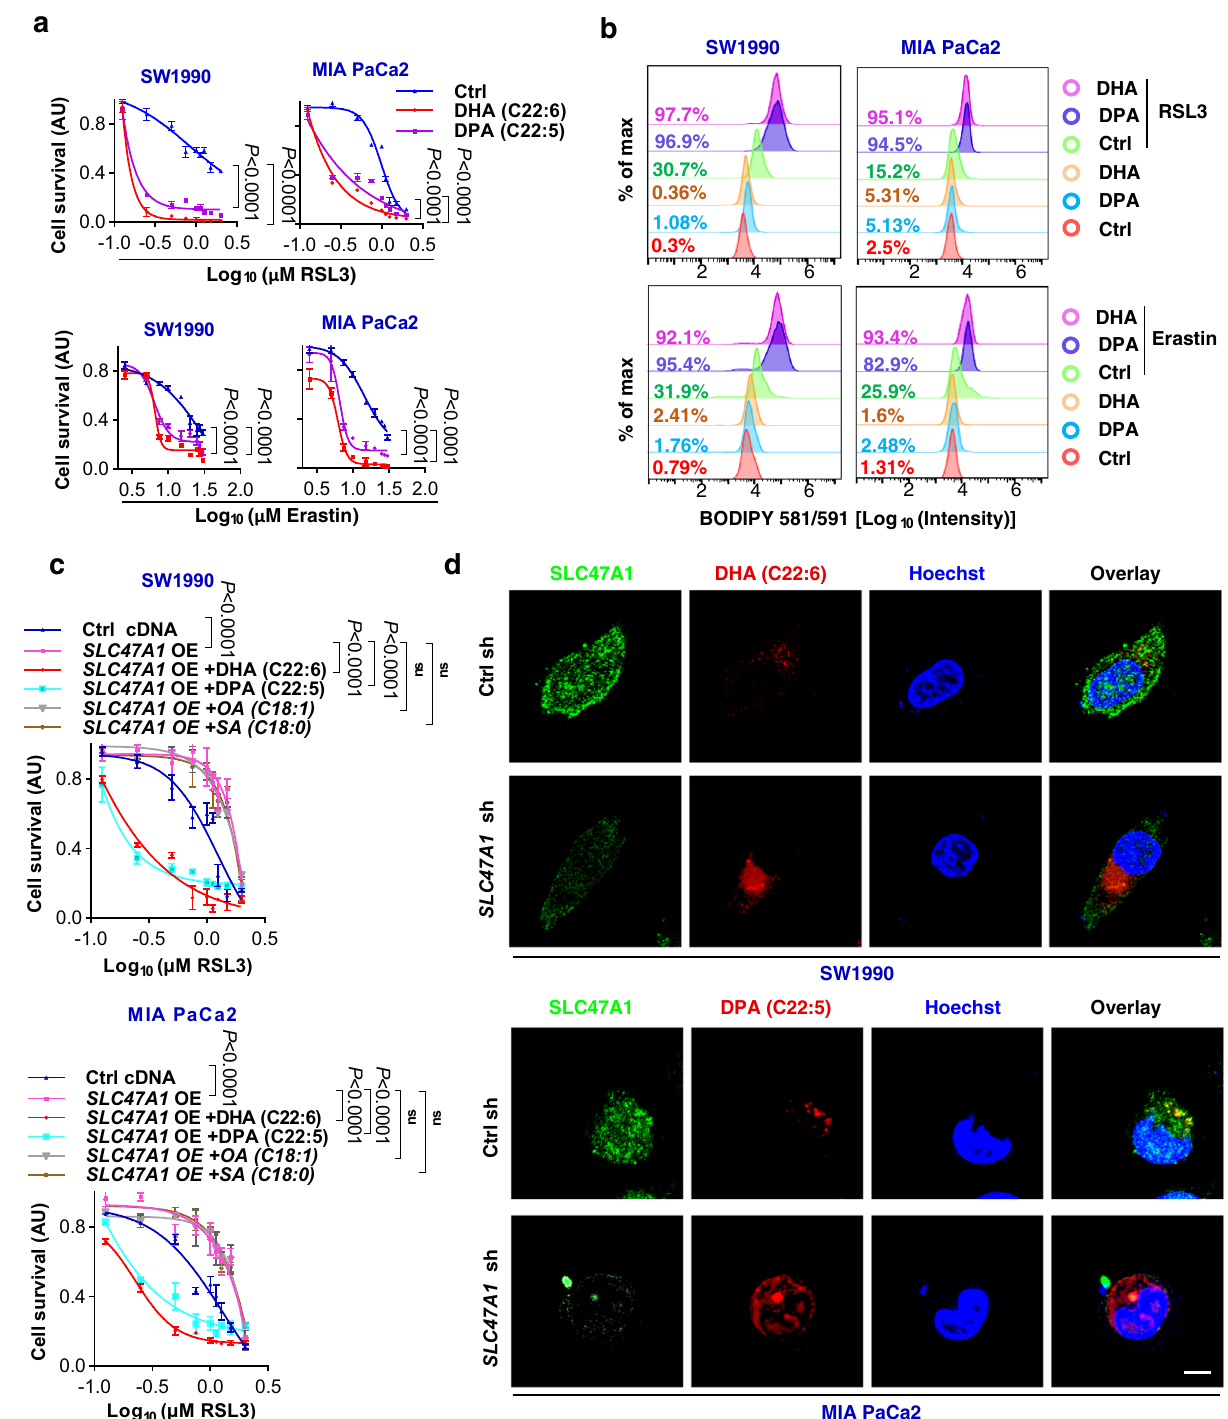
Fig. 4 | DHA/DPA contributes to the ferroptotic sensitivity in SLC47A1 -deple- tion cells. a Indicated cells were pre-treated with DHA (20 μ M) and DPA (20 μ M) for 3 days, and treated with RSL3 or erastin for 24h. Then cell viability were assayed. b Indicated cells were pre-treatment with DHA (20 μ M) and DPA (20 μ M) for 3 days, and treated with RSL3 or erastin for 6h. Then lipid ROS were assayed. The data is representative of three independent experiments. Quanti fi cation results are provided in Supplementary Fig. 4. c Indicated cells were pre-treated with DHA (20 μ M), DPA (20 μ M), SA (20 μ M) and OA (100 μ M) for 3 days, and